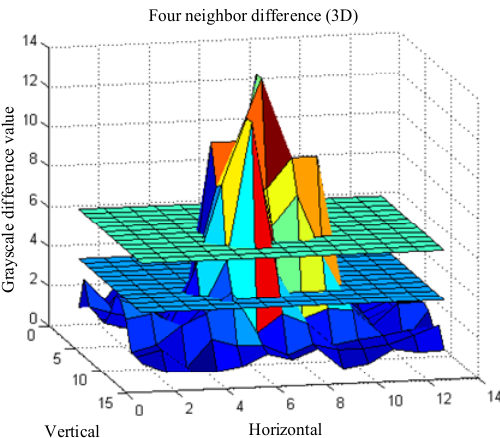
Figure 12. Division of difference with high and low threshold.